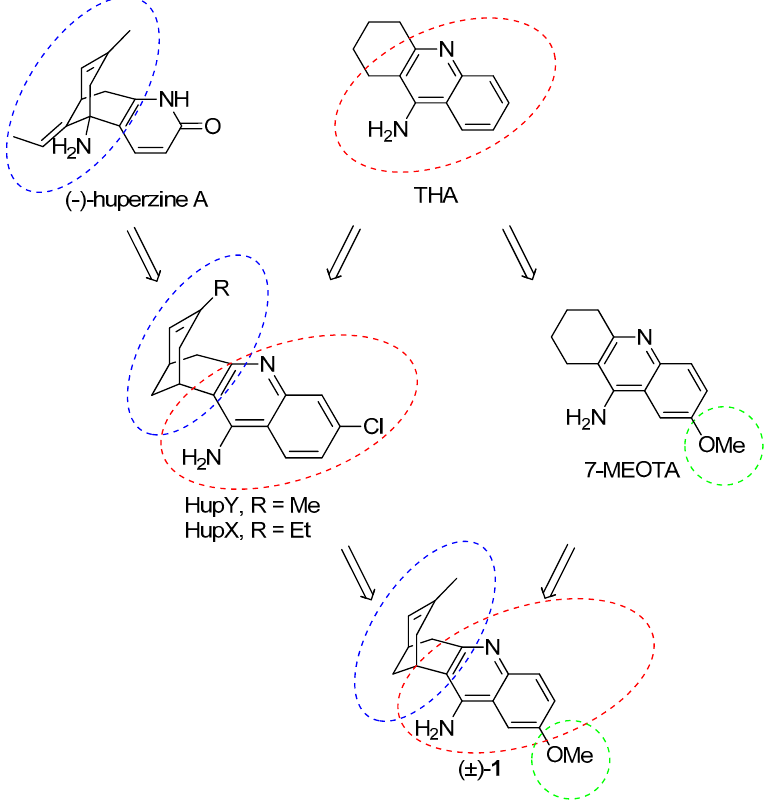
Figure 2. Design strategy towards 2-methoxyhuprine (±)- 1 .